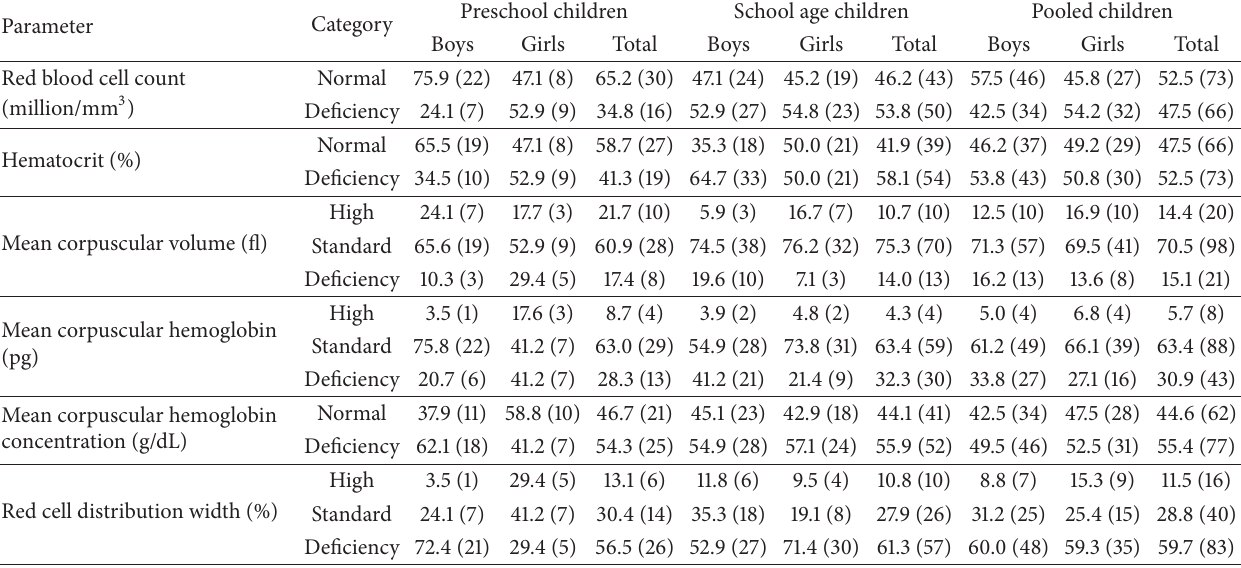
OR = odds ratio, CI = confidence interval; figures in parentheses are sample number. Table 5: Distribution of hematological (red blood cell) indicators by age group and sex among children in Odisha, India.